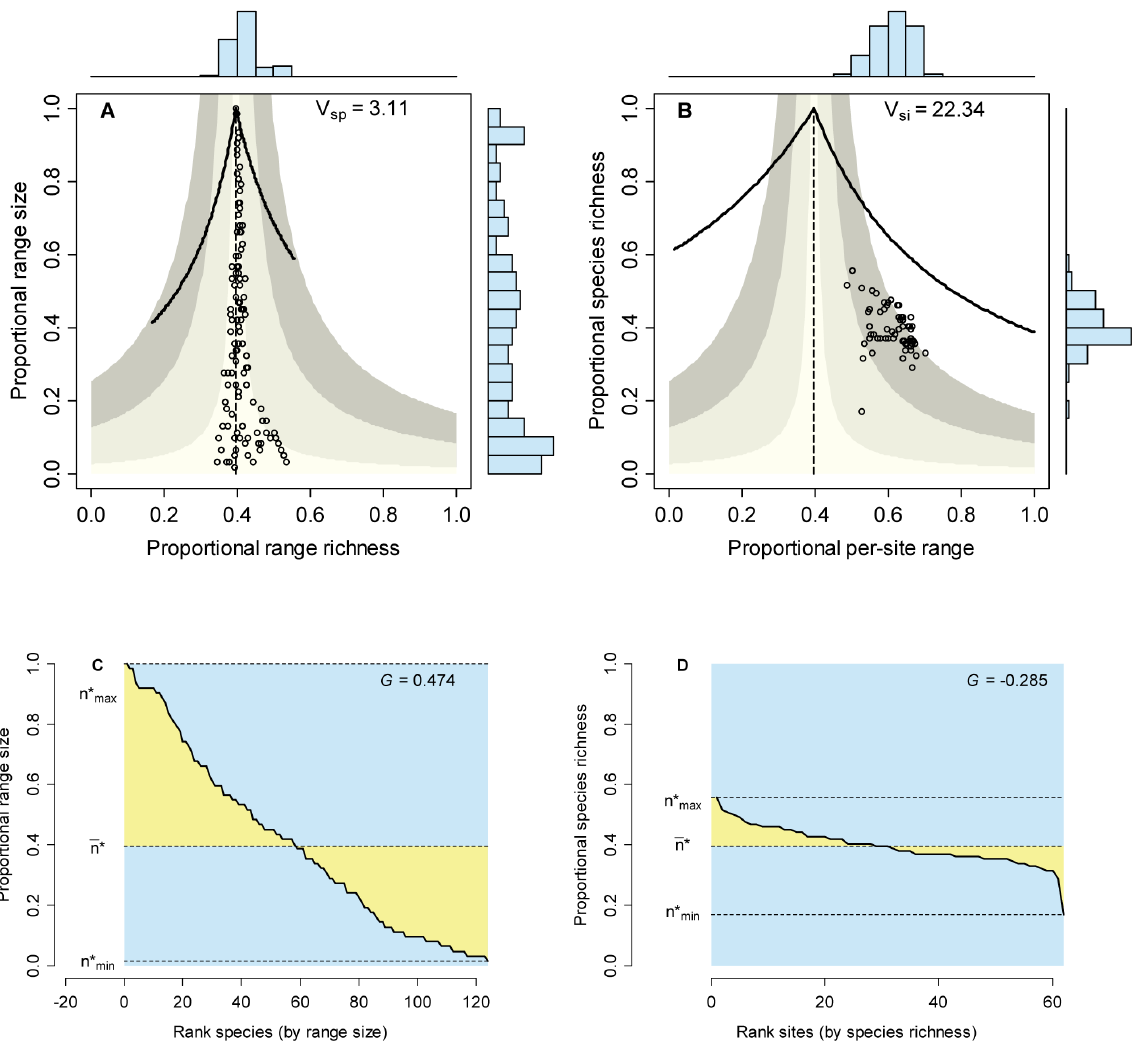
Figure 8. Range-diversity and rank plots for the set of non-volant mammals of central Mexico. Information on RD plots (A and B) as in Figure 2A and B; information on rank plots as in Figures 1, 2C, and